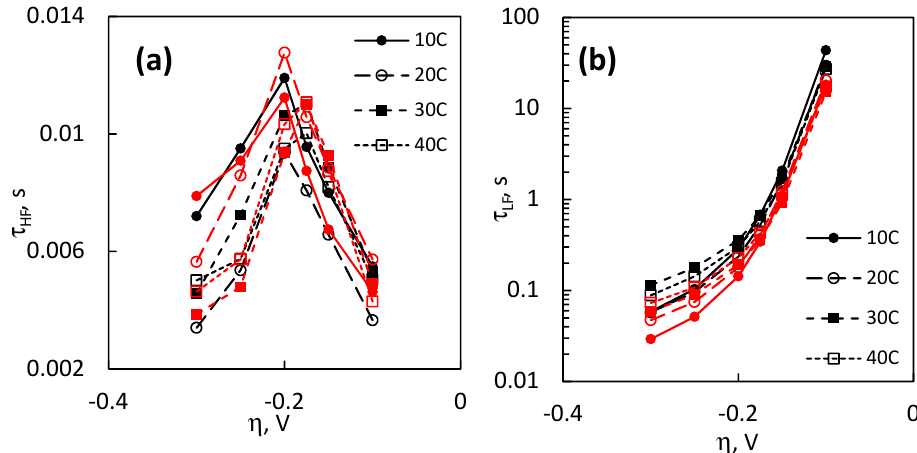
Figure 12. The dependence of ( a ) the high frequency time constant and ( b ) the low frequency time constant on overpotential. (Red lines correspond to samples, deposited with NaH 2 PO 2 ).